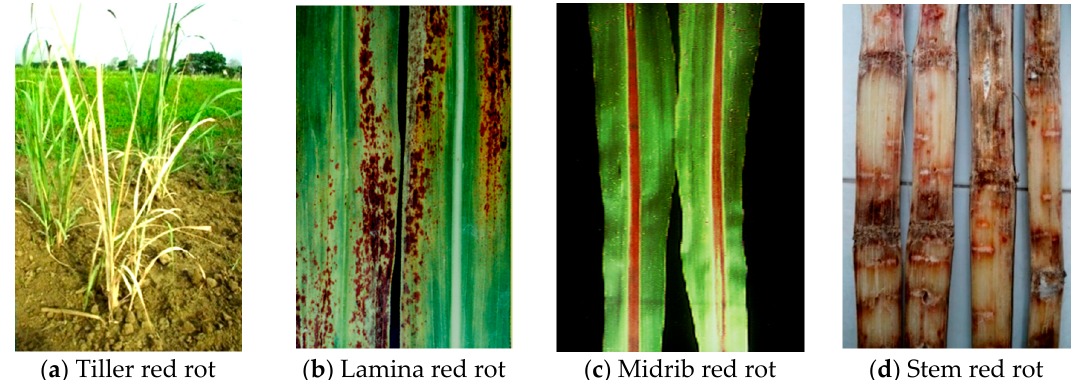
Figure 2. Typical disease symptoms of red rot on different plant parts and stages of sugarcane in the field. note: ( a ) tiller red rot observed at tillering stage; ( b ) lamina red rot, ( c ) mid rib red and ( d ) stem red rot observed at later stage of sugarcane in the field.